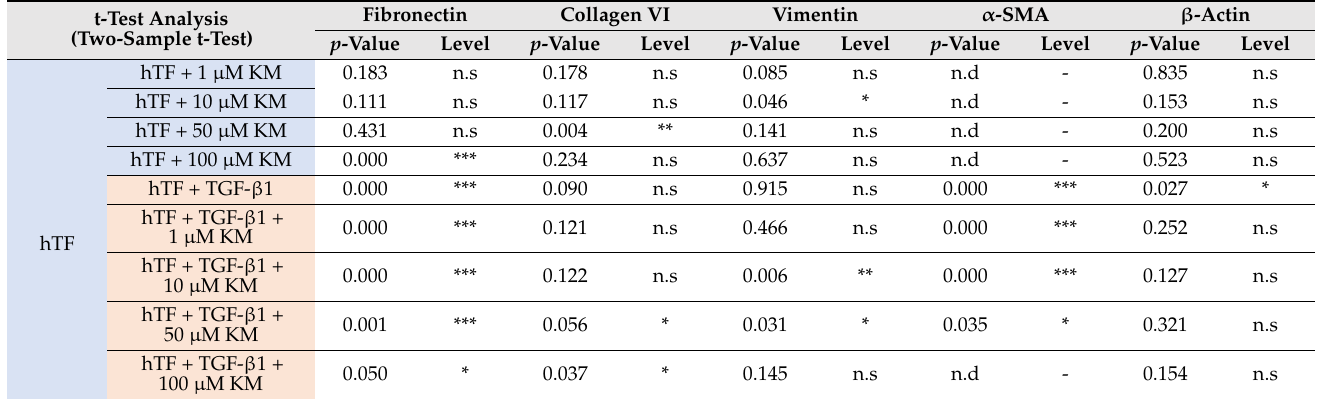
Table 1. Statistical analysis of the Western blot analysis for the in vitro evaluation of the antifibrotic effect of kitasamycin (KM) in a TGF- β 1-mediated fibrotic cell culture model. Statistical analysis was performed by t-test analysis (two-sample t-test). Untreated fibroblasts (hTFs) and TGF- β 1-stimulated fibroblasts (hTFs + TGF- β 1) were compared with the culture approaches. Fibronectin Collagen VI Vimentin α -SMA